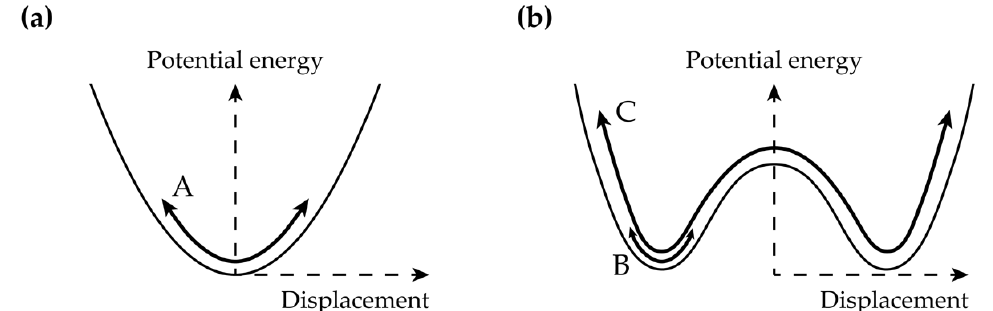
Figure 1. Schematics of the potential energy functions of ( a ) the monostable system and ( b ) the bistable system. In ( a ), the monostable system has only a single-well oscillation plotted by A. In contrast, in ( b ), the bistable system has not only the intrawell motion but also the interwell motion, depicted by B and C, respectively. An attractor for complex chaotic motion might coexist with regular behavior, but the chaotic motion is not investigated in this research.